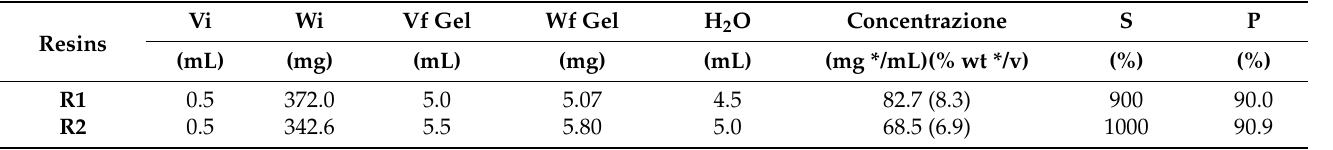
Table 1. Experimental data of R1HG and R2HG preparation and some of their physicochemical